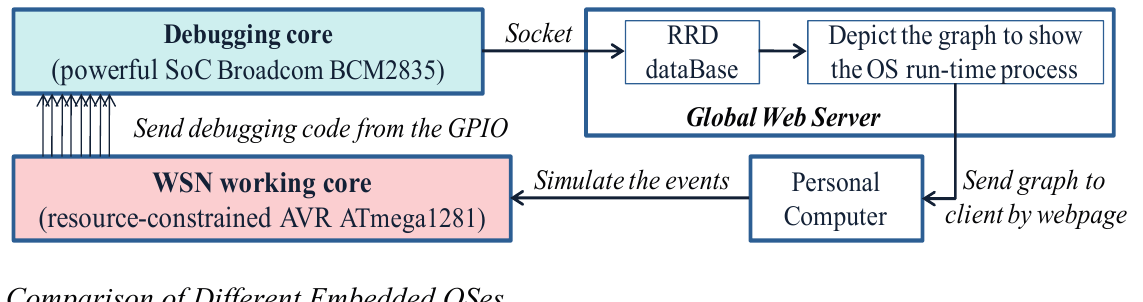
Figure 15. New debugging approach by using the multi-core